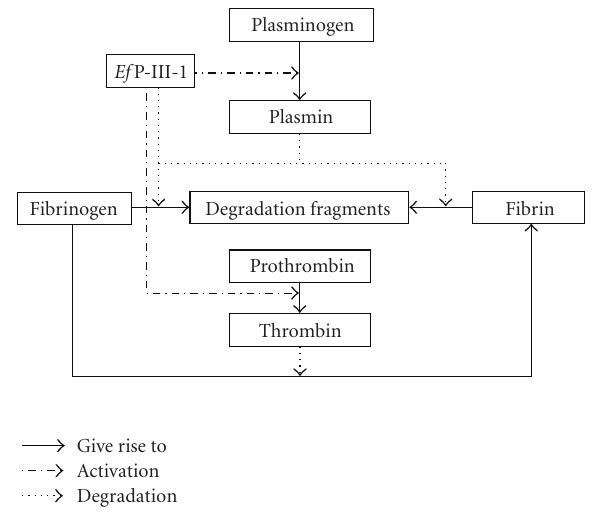
Figure 5: Roles of Ef P-III-1 in procoagulation and anticoagula- tion. Ef P-III-1 degrades fibrin(ogen) and activates not only plas- minogen but also prothrombin. Activation is indicated by dashed lines, and degradation is indicated by dotted